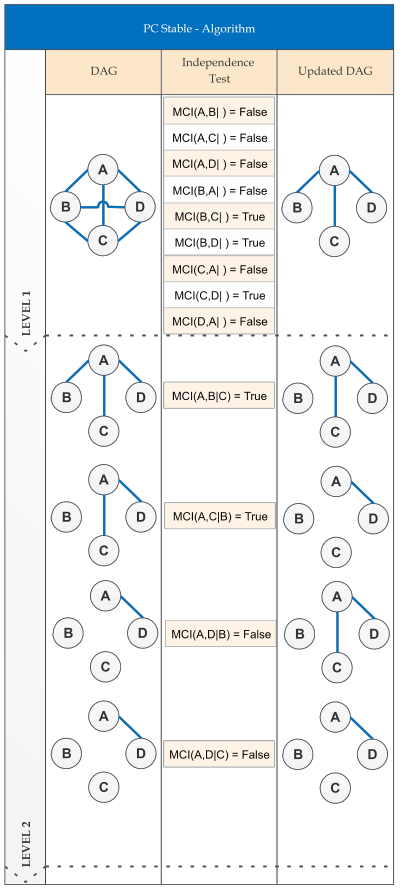
Figure A2. Example of applying PC-Stable algorithm in a hypothetical dataset